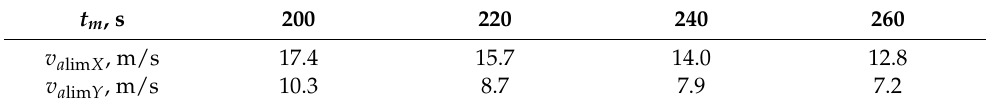
Table 6. Wind velocity limitation in case of X mX —700 m and Y mY —350